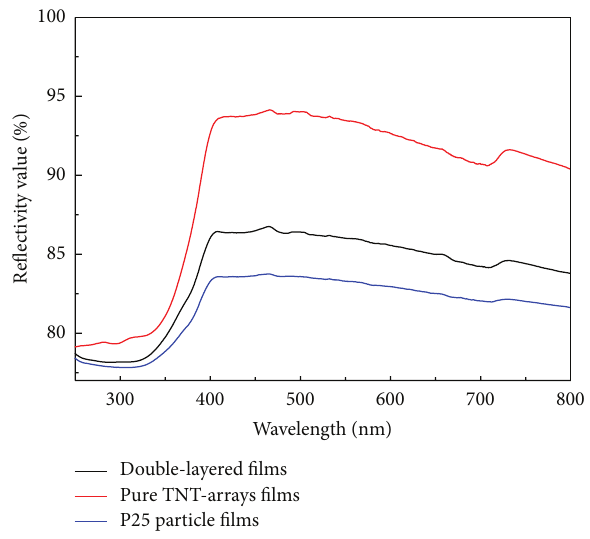
Figure5:DiffusedreflectancespectraofDSSCsbasedonananopar- ticlefilm,aTNT-arraysfilm,andadouble-layeredfilmwithasimilar thickness.